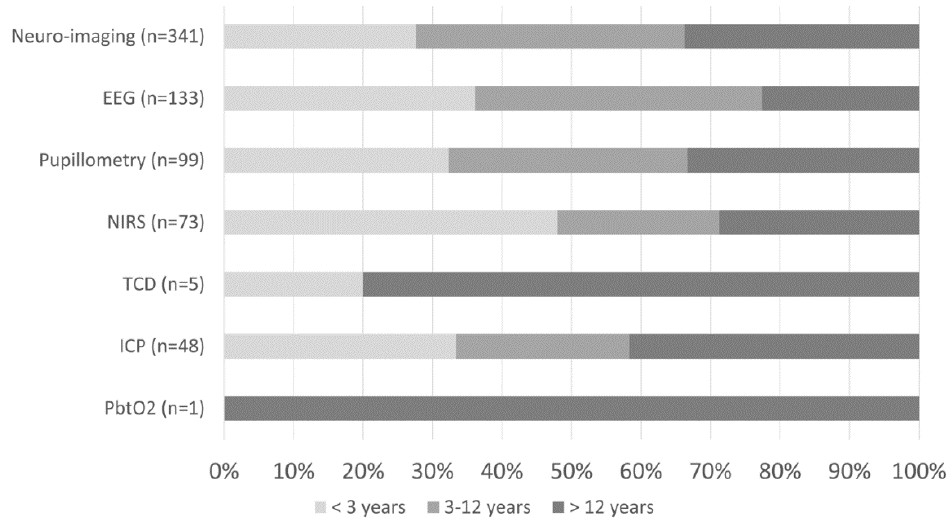
Figure 3. Percentage of neuro-imaging and neuromonitoring use by age group.